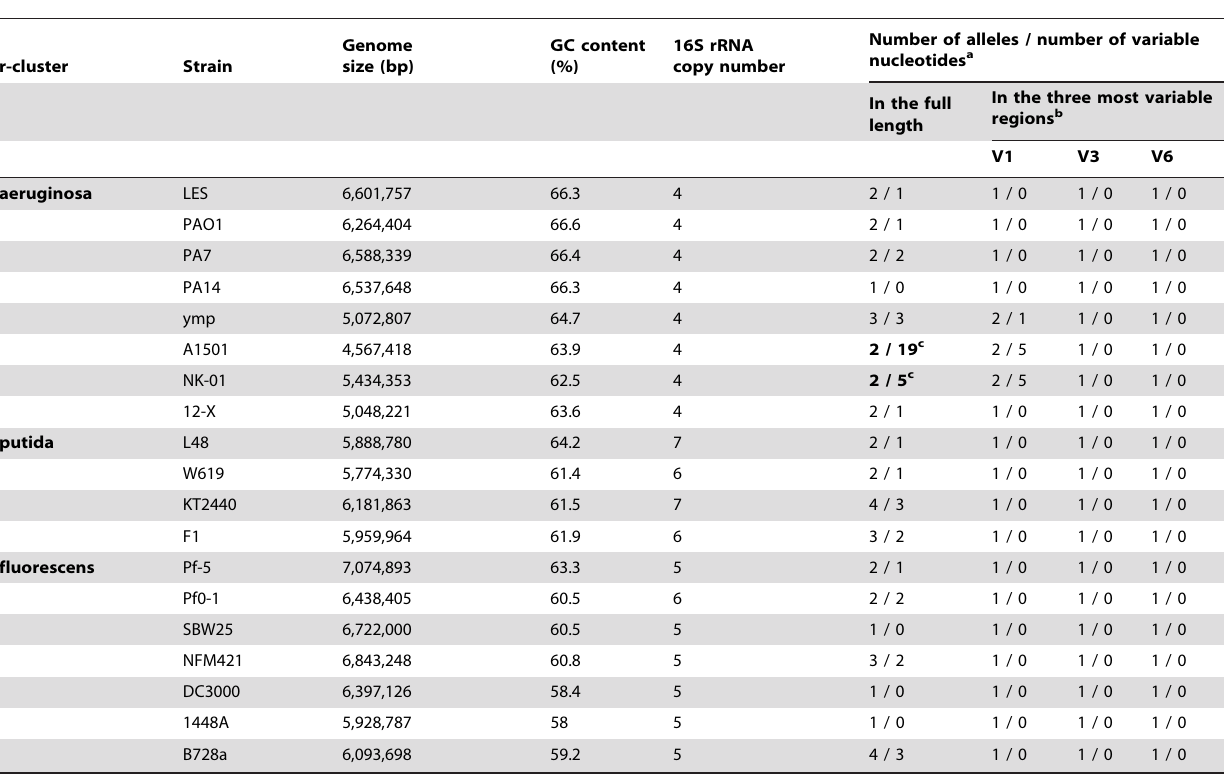
Table 3. Copy number and heterogeneity of the 16S rRNA gene in the sequenced Pseudomonas .